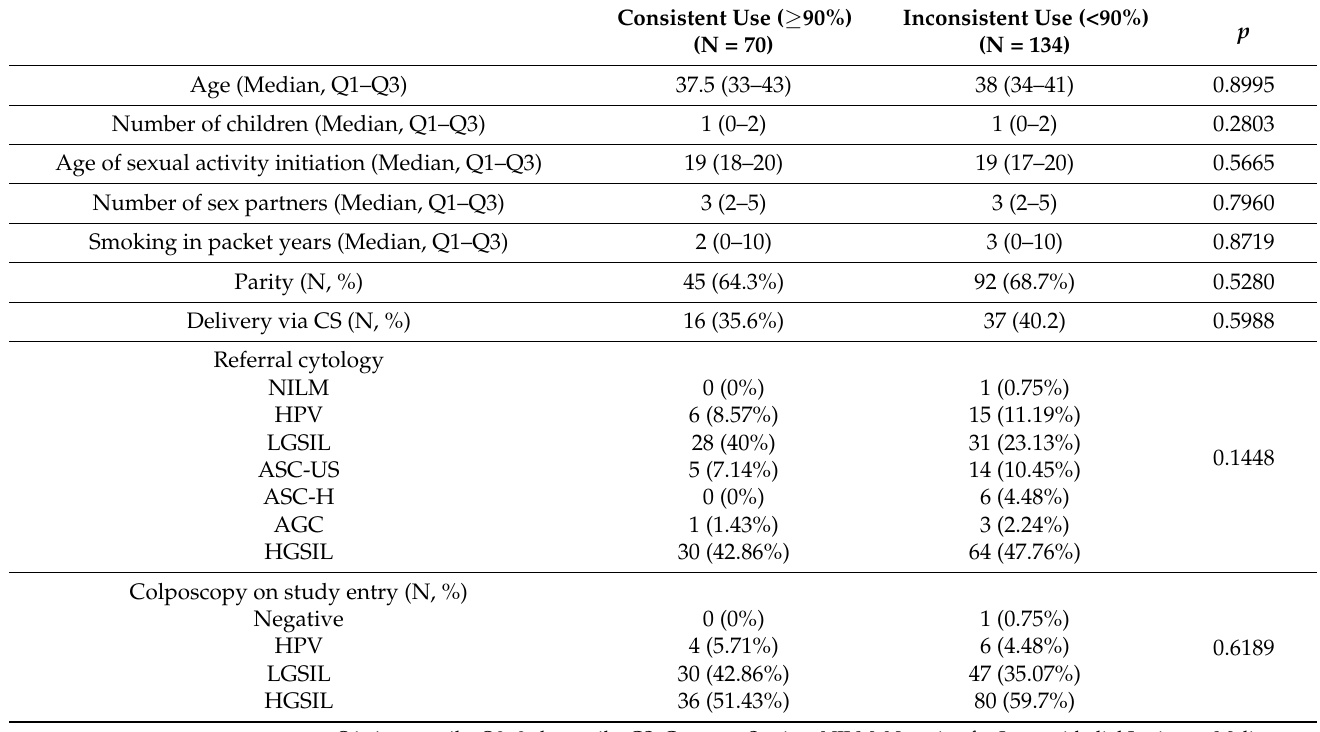
Table 1. Baseline characteristics of the study population.